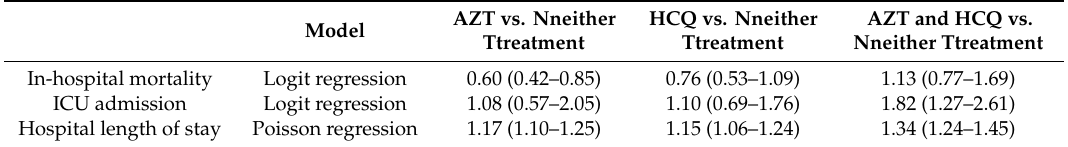
Table 3. Results of adjusted